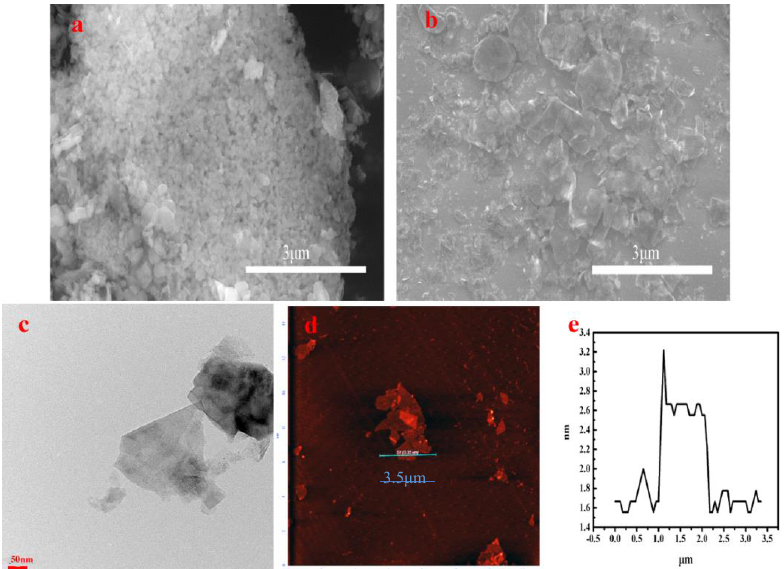
Figure 4. The SEM images of h-BN ( a ) and BNNS ( b ), ( c ) is the TEM image of BNNS, ( d ) are AFM result of BNNS, ( e ) is the thickness of BNNS.